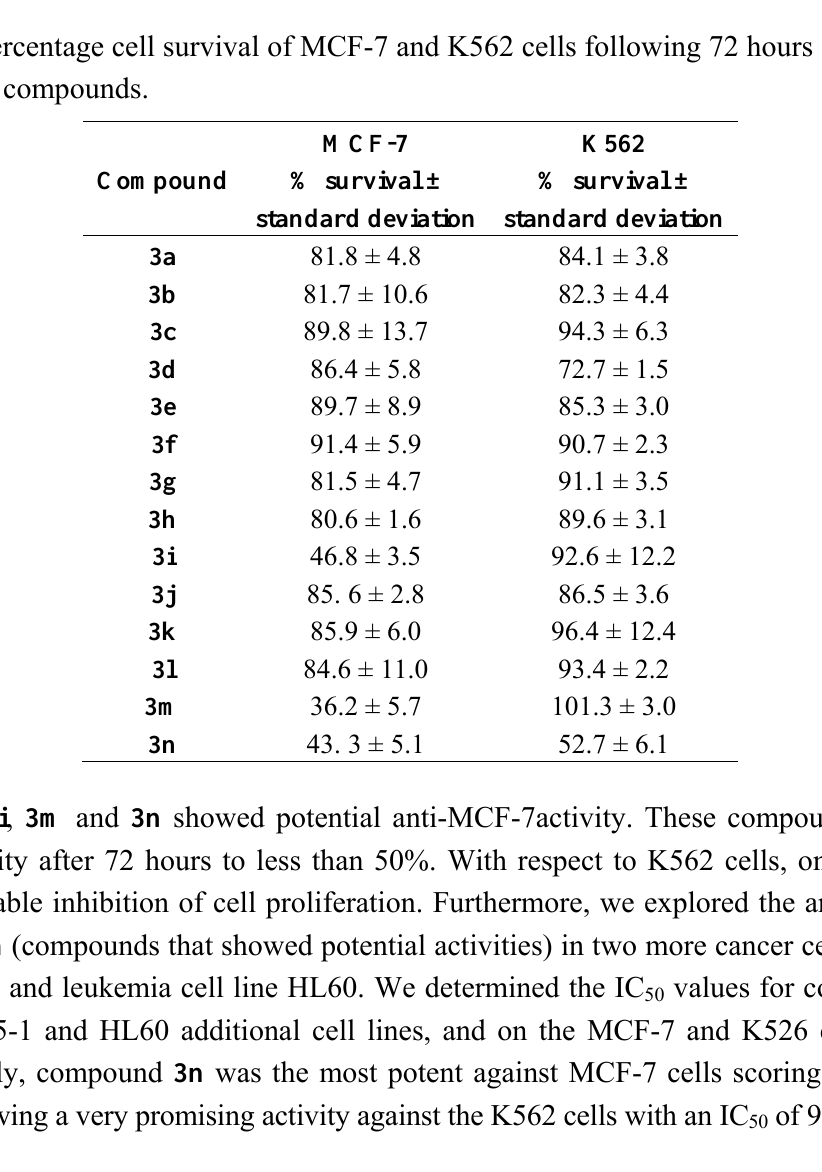
Table 2. Effects of compounds 3i, 3m and 3n on MCF-7, ZR-75-1, K562 and HL60.